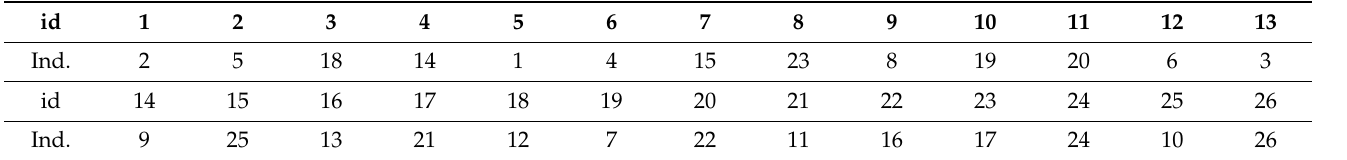
Table 1. Pattern array of the computed Hamlet